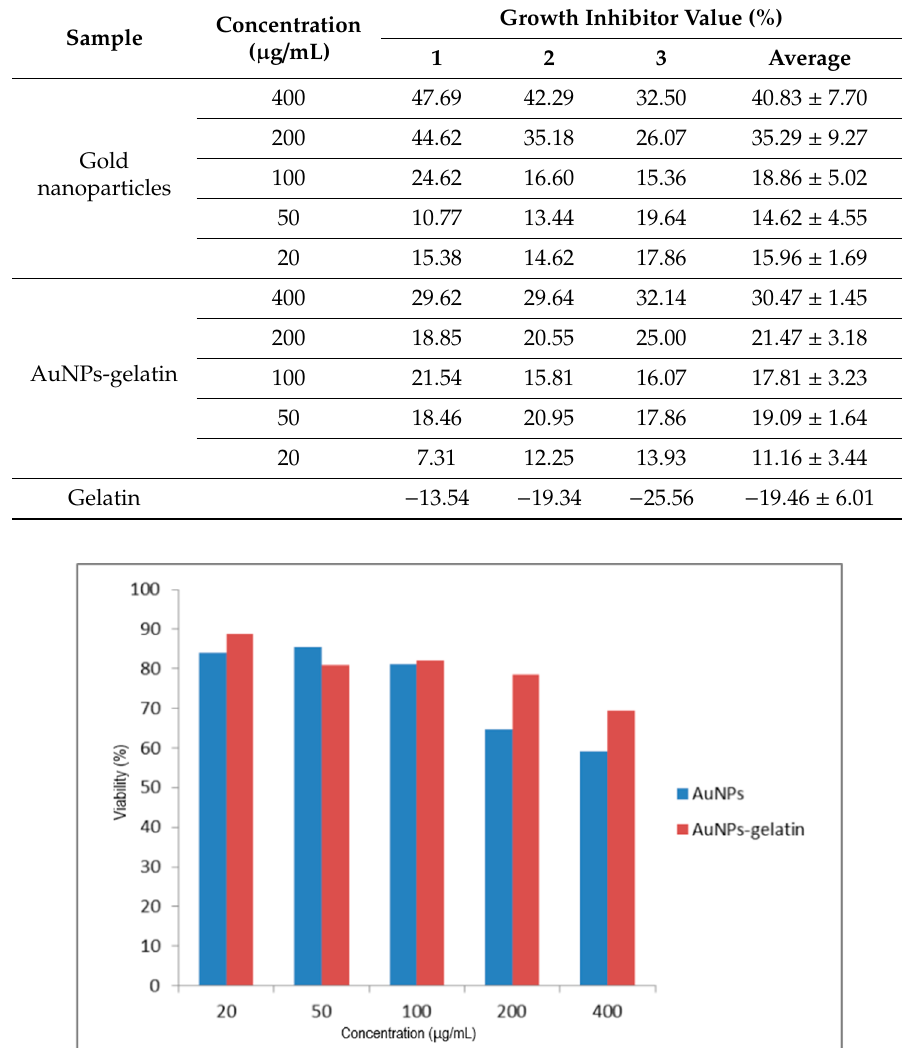
Figure 9. Cell viability of fibroblast cells treated with AuNPs and AuNPs gelatin colloidal solution after 48 h incubation.